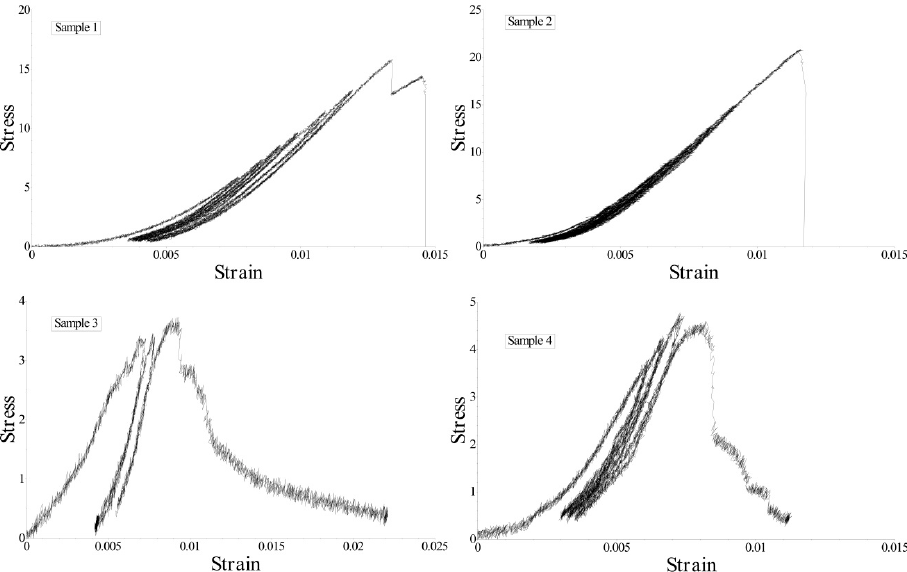
Figure 5. Strain–Stress curves of coal samples subjected to cyclic loading.